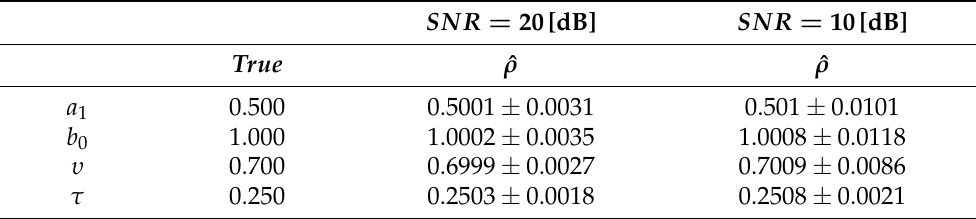
Table 1. Mean and standard deviation of the fractional model parameter estimates obtained by the